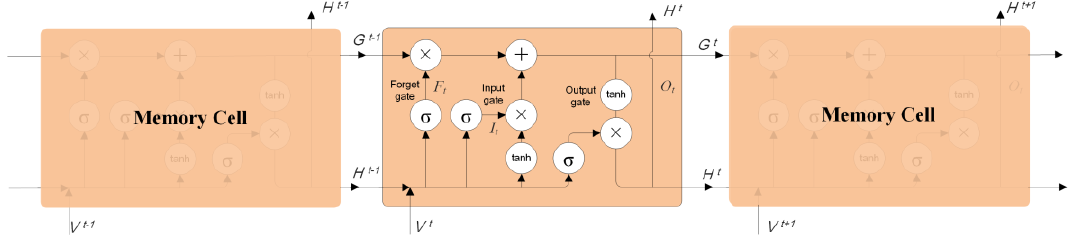
Figure 3. The architecture of long short-term memory neural network (LSTM NN).